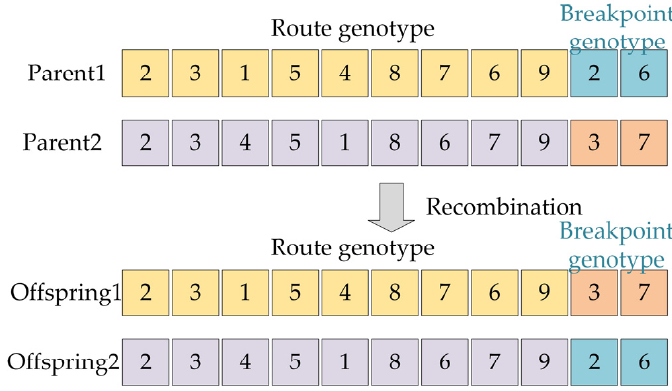
Figure 9. Recombination process.